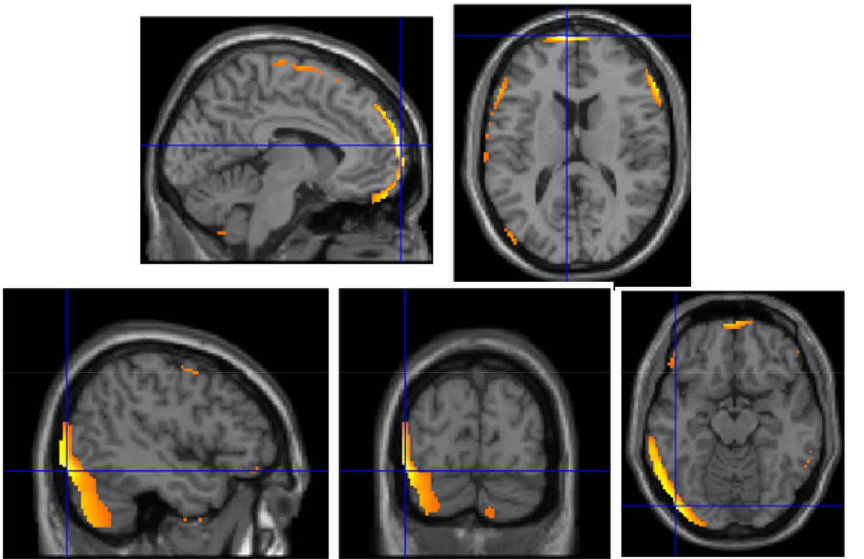
Figure 2. Bilateral medial frontal metabolism (first row) and left temporo-occipital metabolism (second row) were significantly preserved in HT + women who were ApoE- e 4 negative, compared to HT 2 women who were ApoE- e 4 negative. Color voxels shown above have significance of p , 0.001.